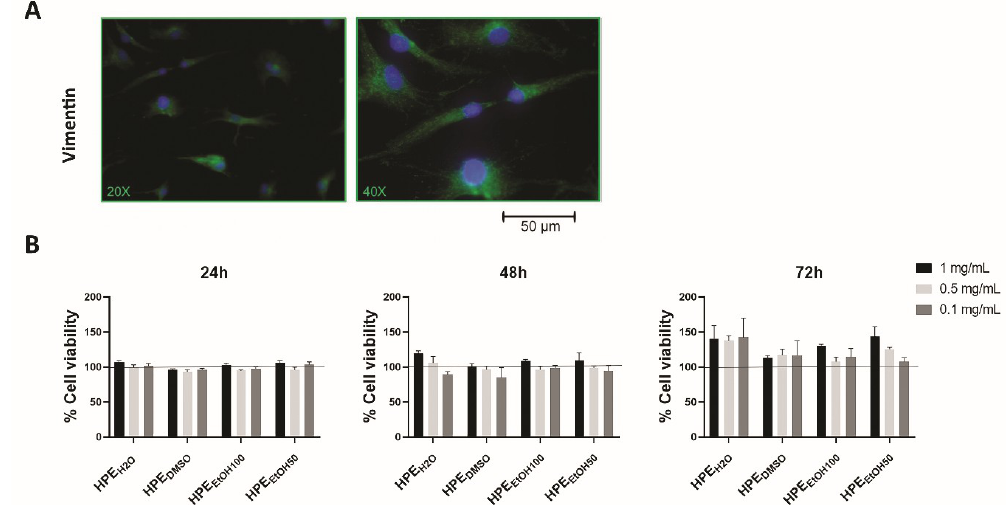
Figure 2. Characterization of human primary synoviocytes (FLSs) and analysis of cell viability. ( A ) Human primary FLSs, isolated by synovial membranes and cultured in vitro, were stained with anti-vimentin primary antibody and with Alexa Fluor 488 (green) secondary antibody. ( B ) Cell viability was assessed by the MTS colorimetric method, and FLSs were treated with three concentrations, 1, 0.5, and 0.1 mg / mL of Harpagophytum procumbens root extract (HPE) dissolved in deionized water (HPE H2O ), DMSO (HPE DMSO ), 100% v / v EtOH (HPE EtOH100 ), and 50% v / v EtOH (HPE EtOH50 ), for 24, 48, and 72 h. Cell viability of treated samples was normalized to the untreated cells, which is reported as 100% and represented by a horizontal line.